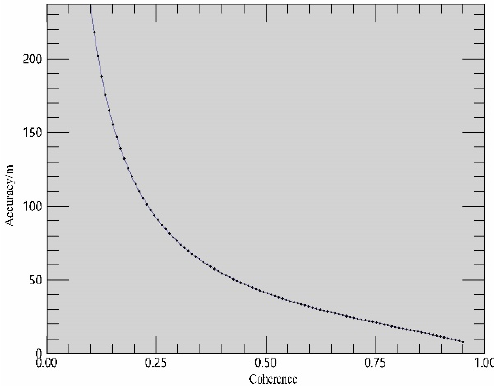
Figure 7. Relationship diagram between Sentinel-1 elevation accuracy and coherence.